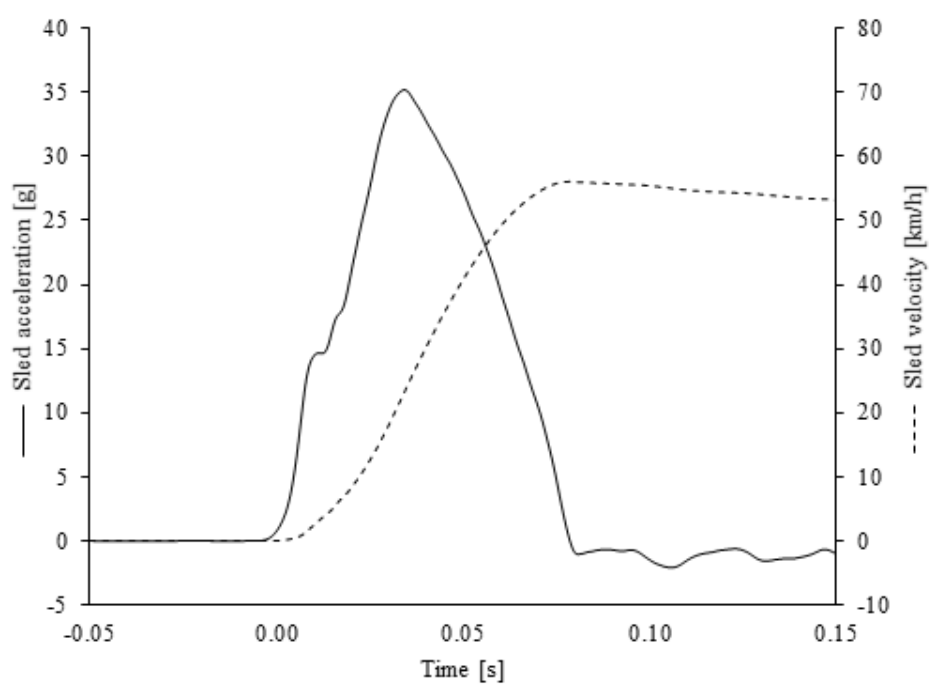
Figure 2. Exemplar sled acceleration (solid line) and velocity (dashed line) profiles for the simulated Consumer Reports frontal impact crash